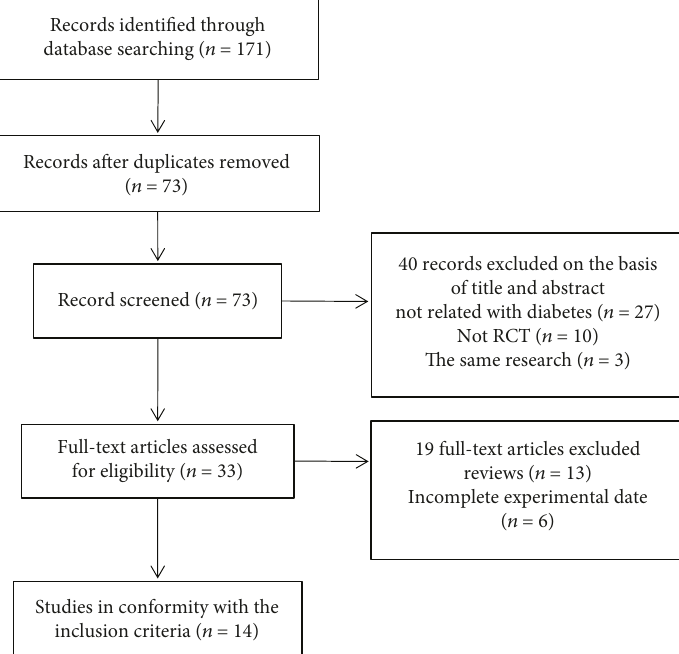
Figure 1: Flowchart of trial selection